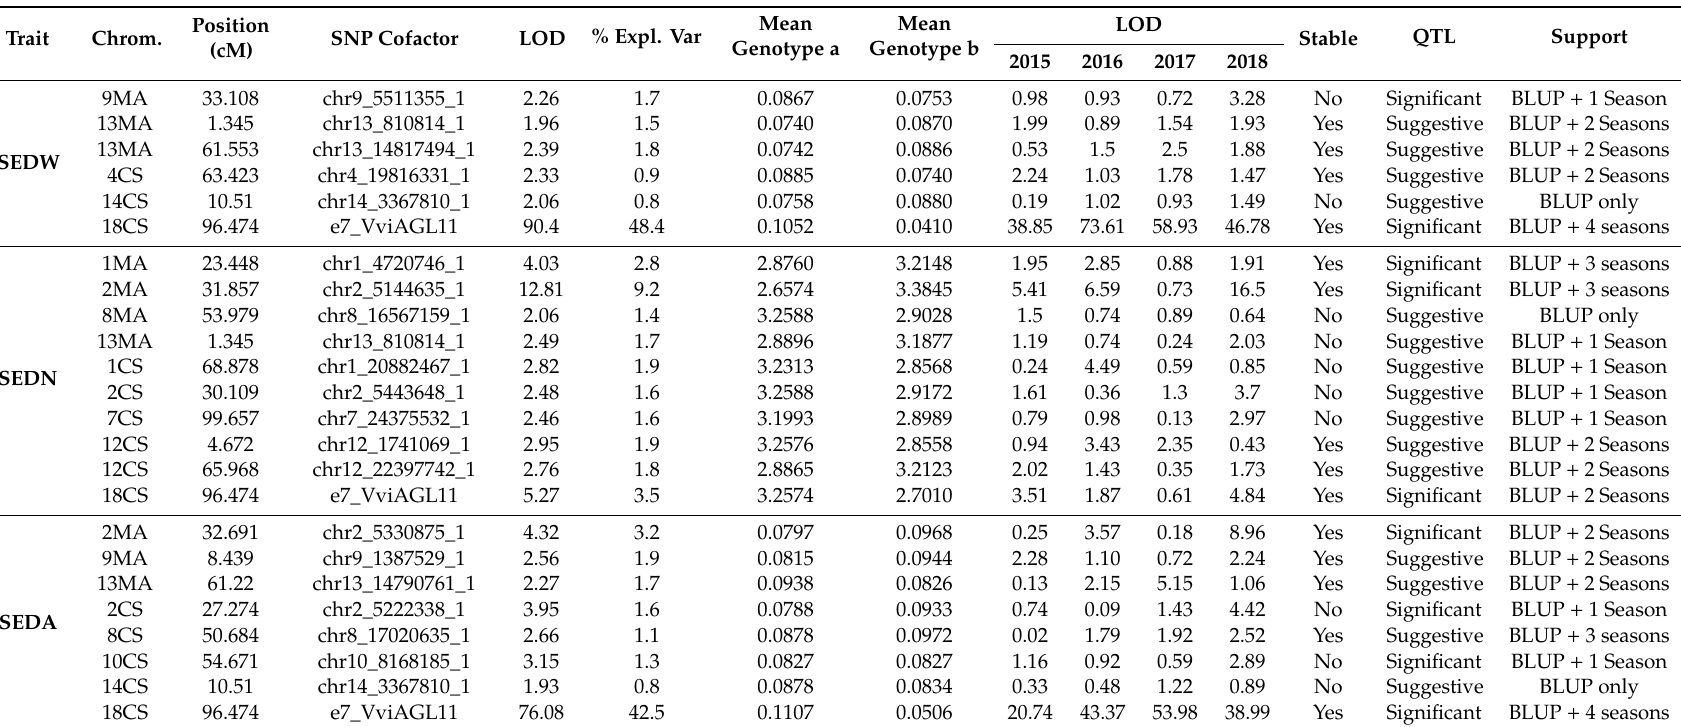
Table 1. QTLs detected for seedlessness in the MA × CS population during four